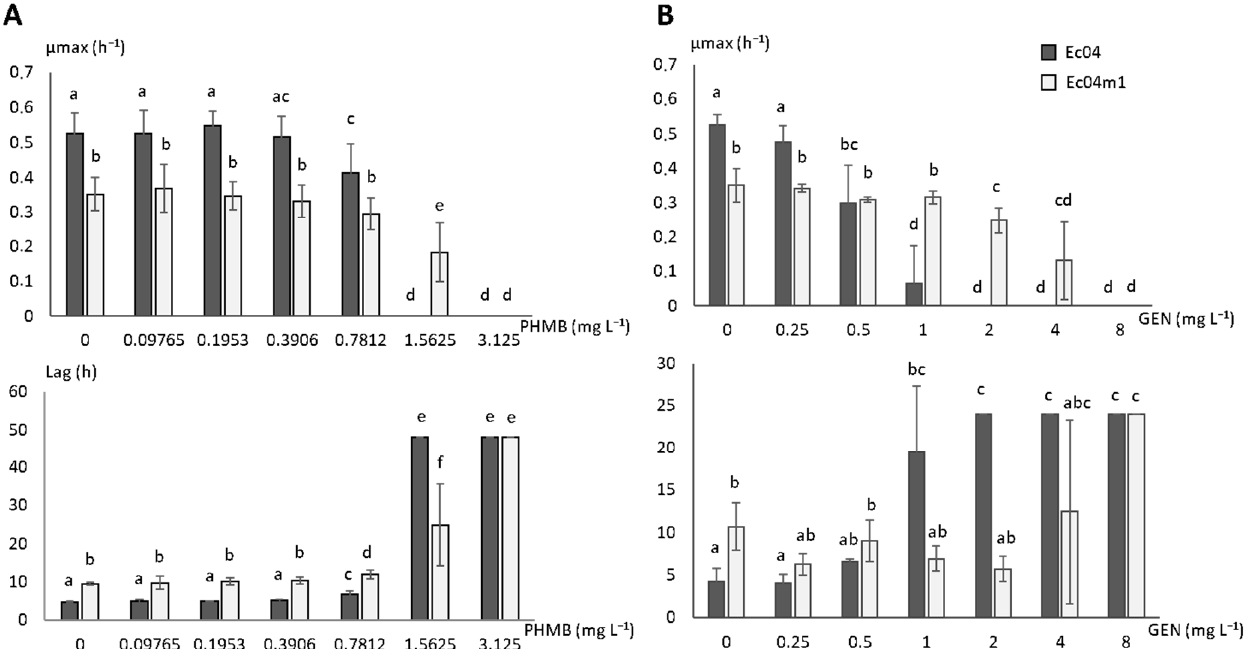
Figure 2. Maximum growth rate ( µ max) and lag time (lag) for parental strain Ec04 and Ec04m1 variant in the presence of ( A ) PHMB concentrations from 0 to 3.125 mg L − 1 , or ( B ) GEN from 0 to 8 mg L − 1 . Different letters upon the SD bars indicate significant differences between µ max or lag mean values (T-test. p < 0.05).